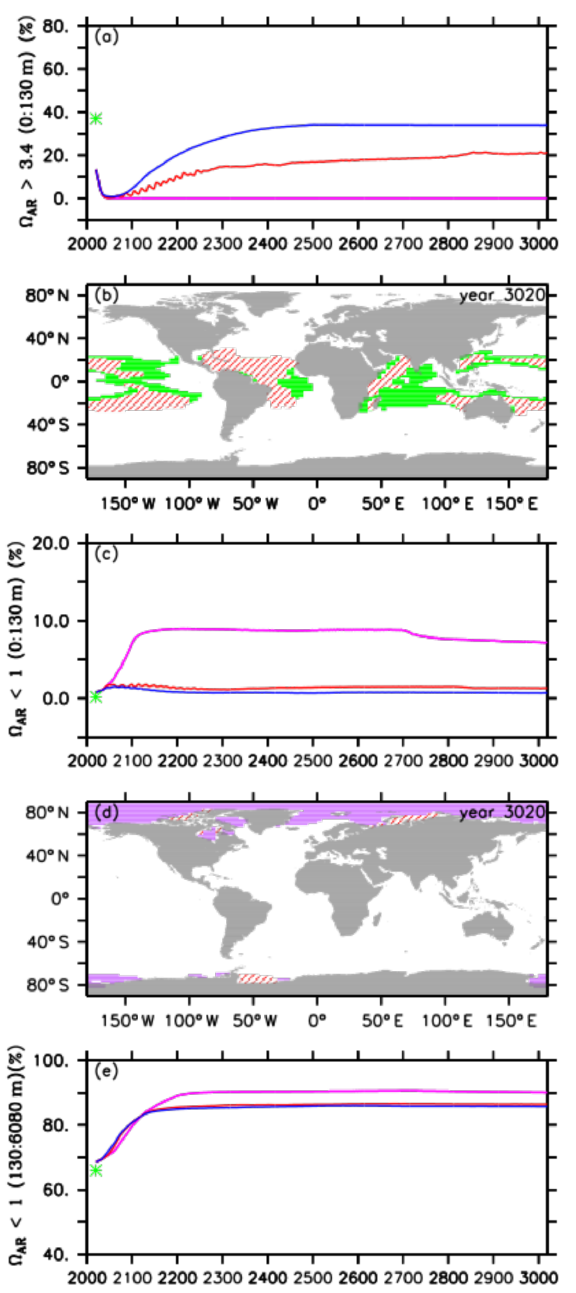
Figure 5. Comparison of volumes for different saturation states be- tween preindustrial levels (green stars), the default RCP4.5 control run (purple lines), the A2 simulation (red lines), and the A3 simu- lation (blue lines) for (a) omega aragonite > 3.4 in the upper ocean (0 to 130m depth), (b) potential coral reef habitat defined as the vol- ume of the global upper ocean (0 to 130m depth) with omega arag- onite > 3.4 and ocean temperatures between 21 and 28 ◦ C for prein- dustrial levels (green) and the A2 simulation (red hatching) in the year 3020, (c) omega aragonite < 1 in the upper ocean (0 to 130m depth), (d) the global distribution of omega aragonite < 1 for the de- fault control run (purple) and the A2 simulation (red hatching), and (e) omega aragonite < 1 in the intermediate and deep ocean (130 to 6080m depth).